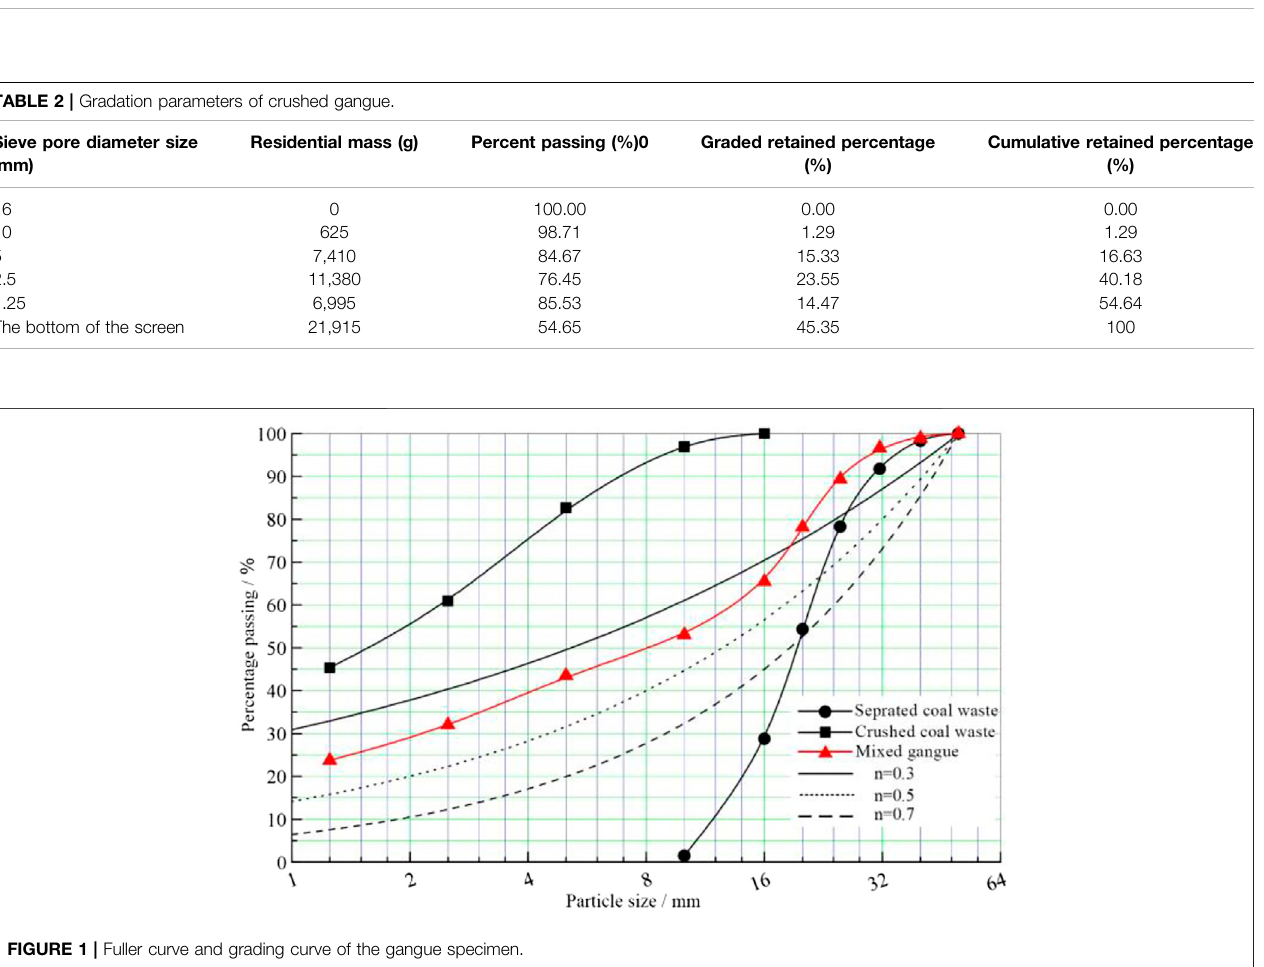
FIGURE 1 | Fuller curve and grading curve of the gangue